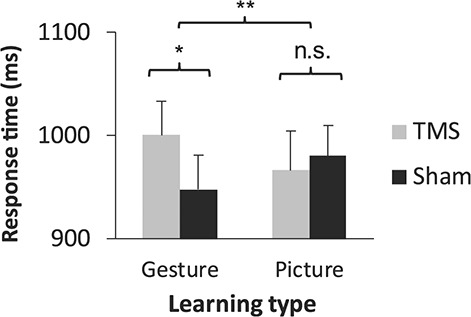
Effects of bmSTS stimulation on speed of L2 translation. Bilateral bmSTS stimulation slowed the translation of L2 vocabulary learned using gestures compared with sham stimulation in the multiple-choice task. There was no such effect for L2 vocabulary learned using pictures. The mean of each condition across time points (5 days and 5 months following the start of learning) is shown (n = 22 participants). Error bars represent one standard error of the mean. *P < 0.05, **P < 0.01.